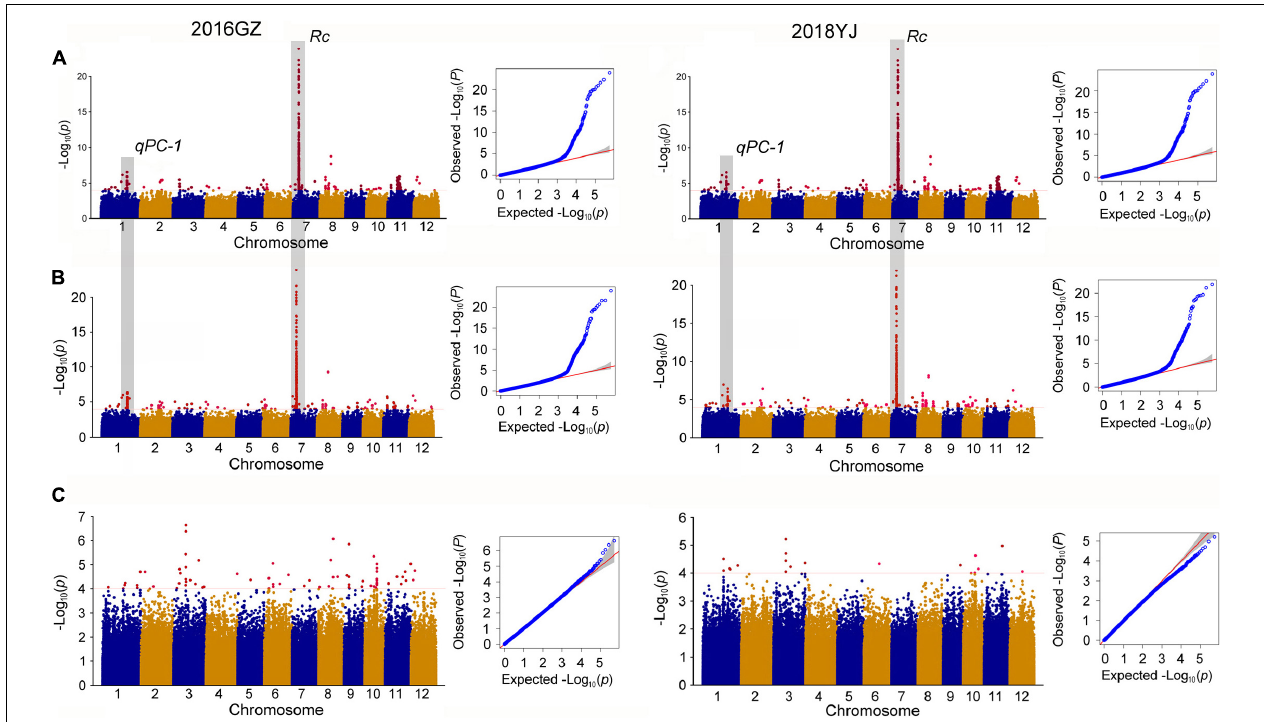
FIGURE 2 | Genome-wide association study for PC. (A,B) Manhattan plots of GWAS in 12 chromosomes and QQ plots of p -values conducted in the whole population using the PA and DPC phenotyping method, respectively. PA method, pericarp color were evaluated based on presence or absence of pigmentation; DPC method, pericarp color were evaluated based on the degree of pericarp color (DPC) using the visual card with scores of 1–7. (C) Manhattan plots of GWAS in 12 chromosomes and QQ plot of p -value conducted in the colored